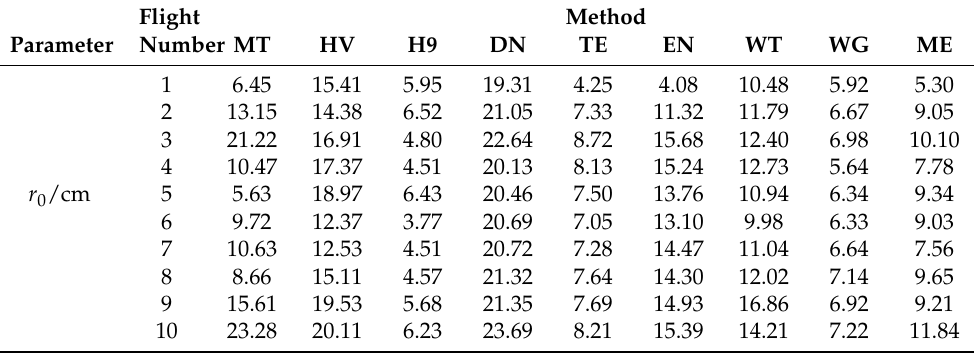
Table A3. ECACN integrated astronomical parameters details ( r 0 @ λ = 550